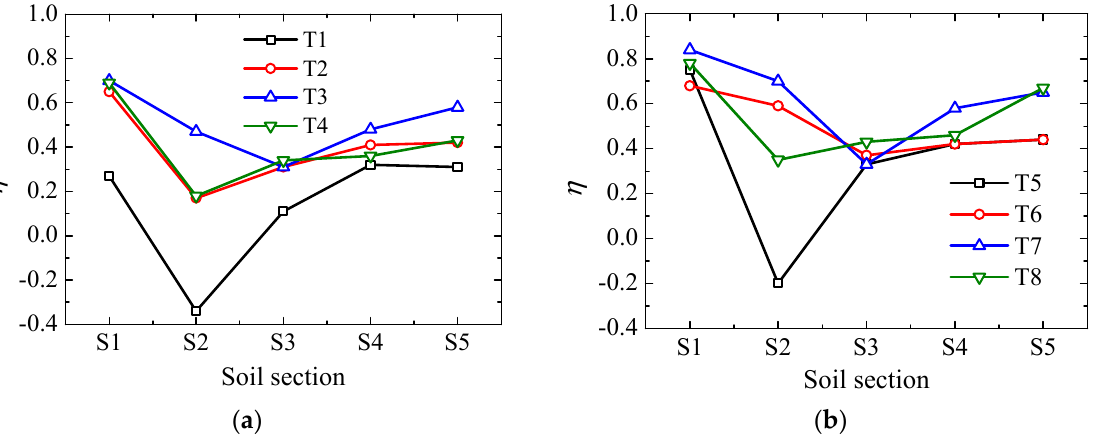
Figure 6. Copper removal effect before and after electric repair. ( a ) EK Remediation; ( b ) EK − PRB Remediation.